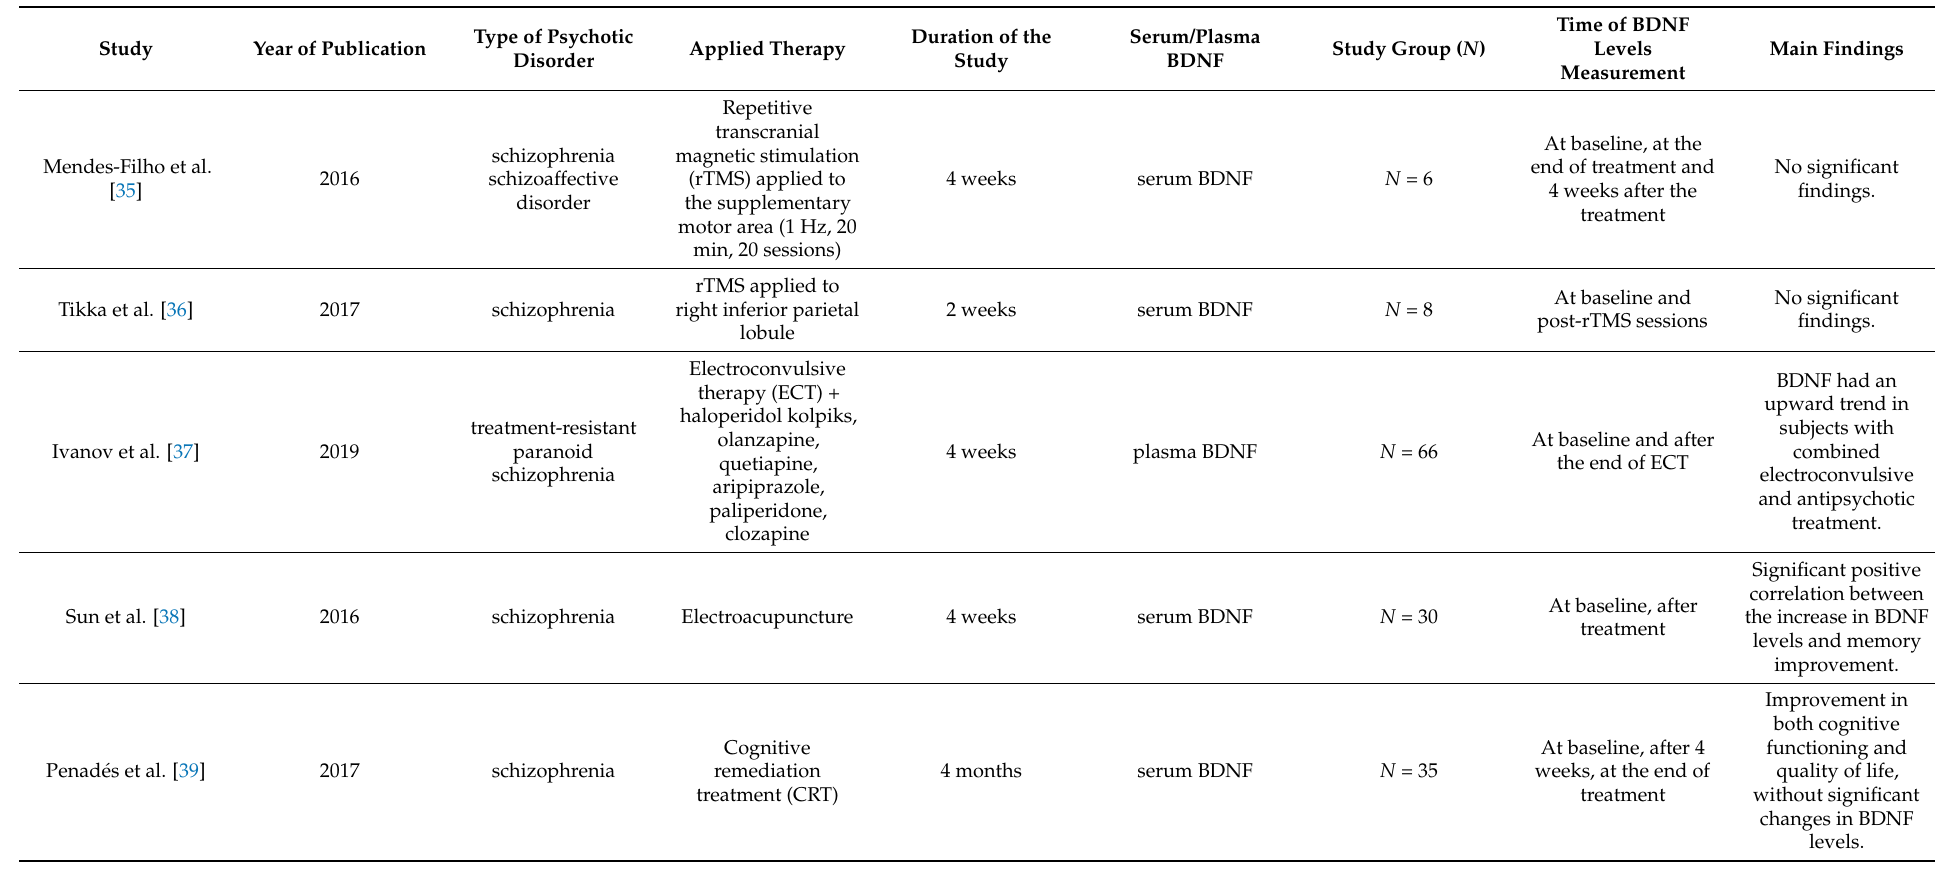
Table 2. The influence of non-pharmacological treatment in psychotic disorders on